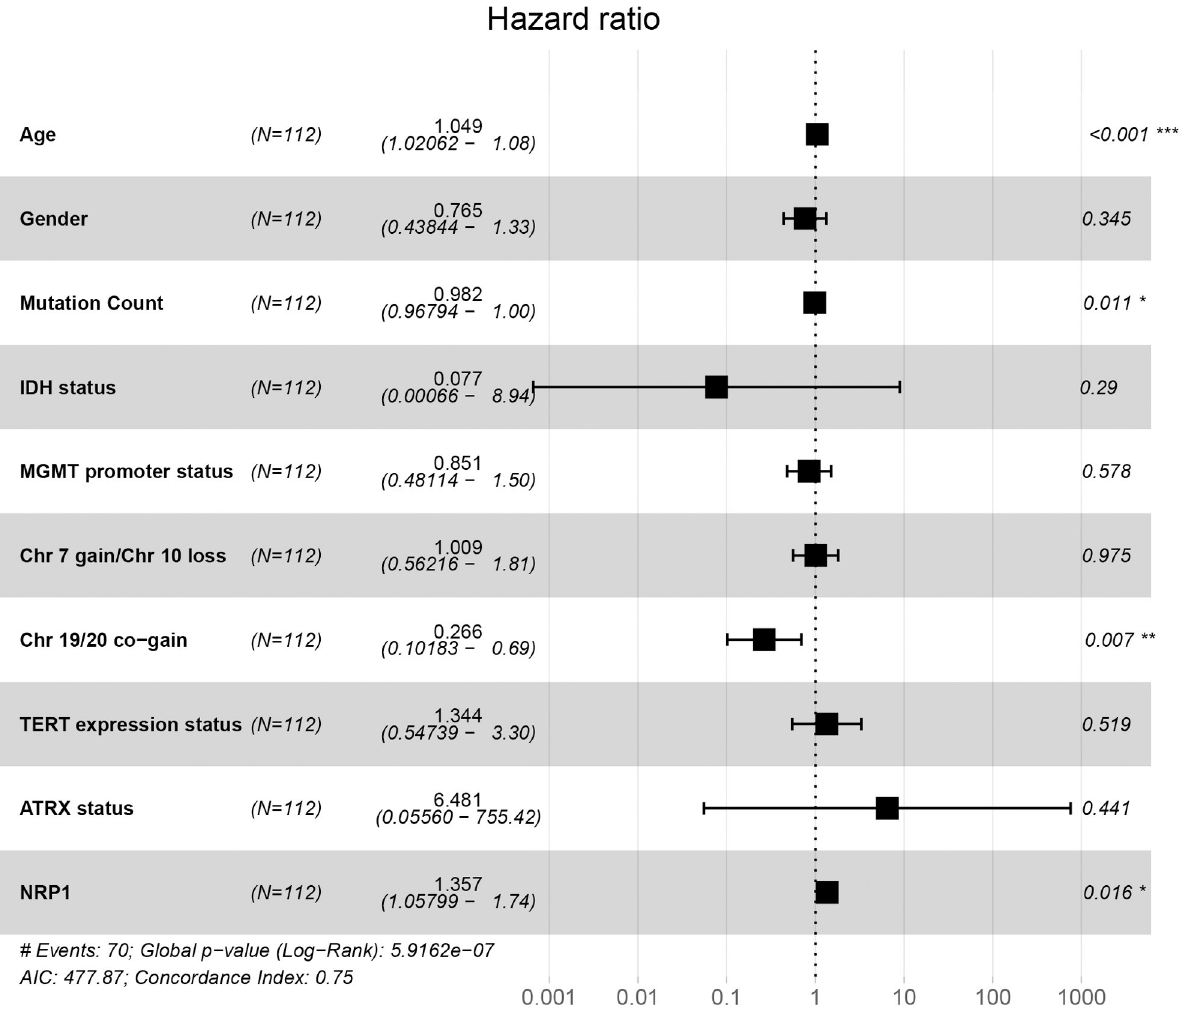
Fig 7. Multivariate Cox analysis of NRP1 . NRP1 and multiple GBM features were used to analyze whether NRP1 was an independent prognostic factor for